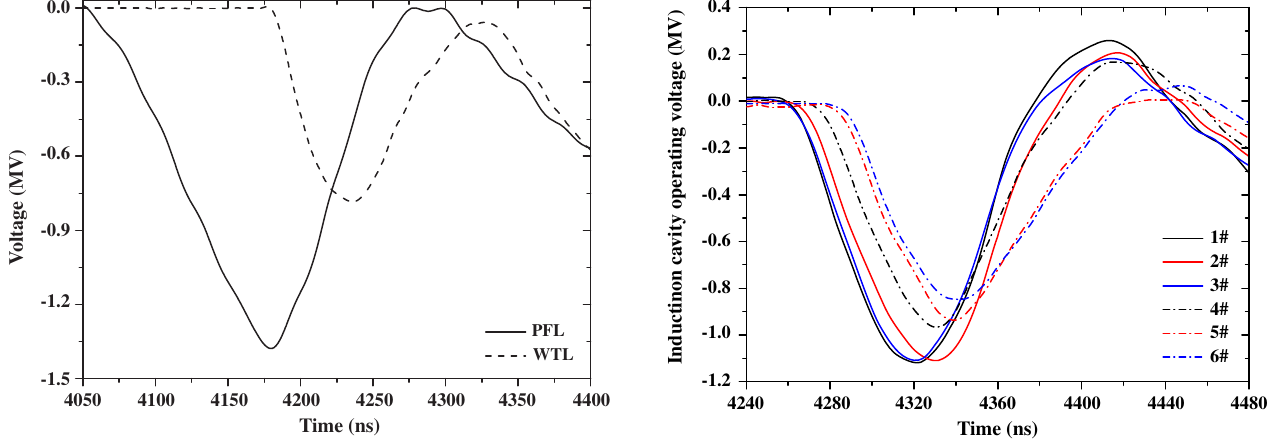
FIG. 11. Voltage waveforms of the six induction cavities. They were acquired by the D-dot probes at the center of the feed port sections.